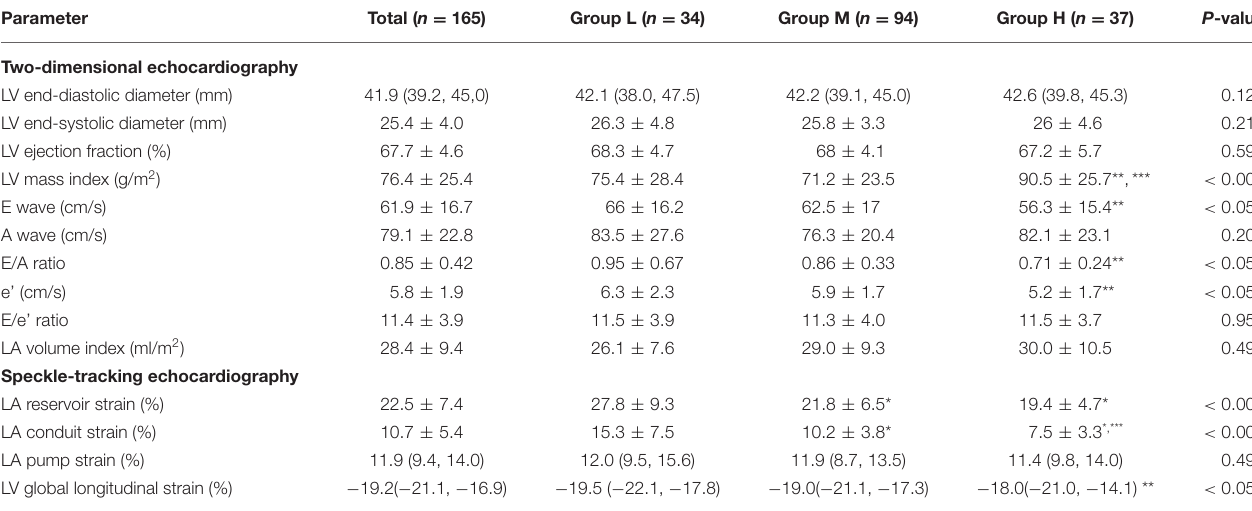
TABLE 2 | Comparison of echocardiographic parameters among the study groups. Parameter Two-dimensional echocardiography